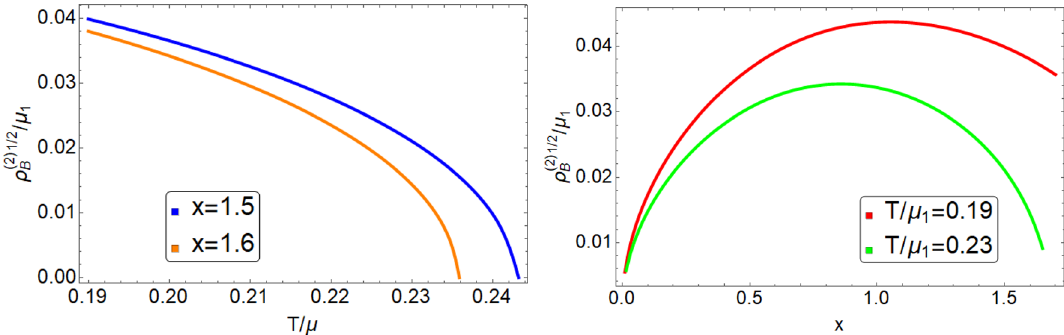
Figure 3 . The CDW amplitude ρ (2)